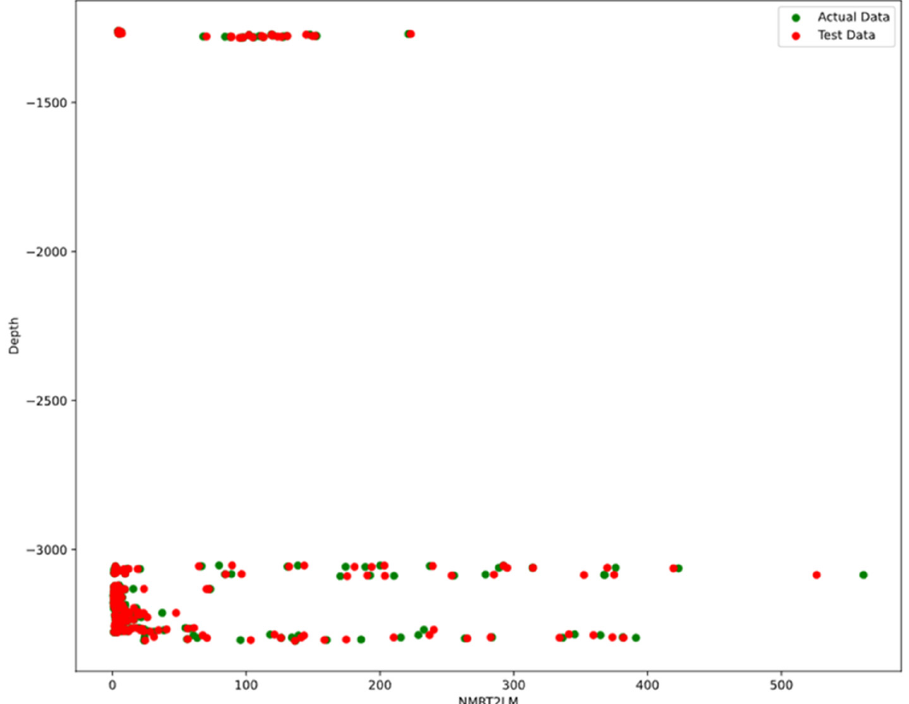
Figure 17. Comparison of predicted and test data for the two reservoir intervals.